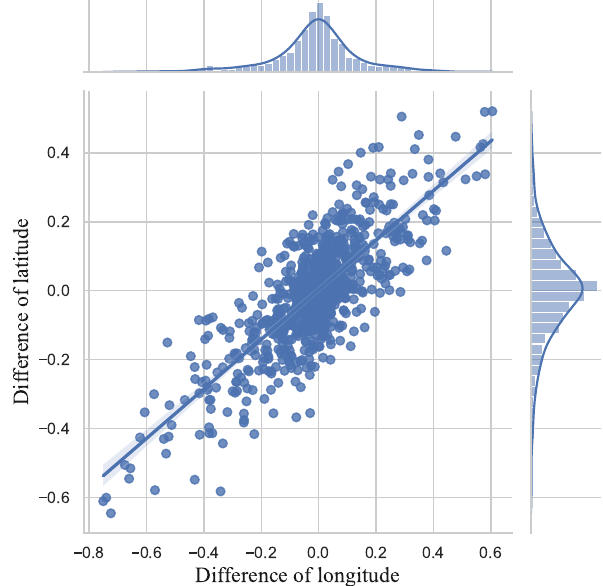
Figure 19. Plot of lightning spatial localization results for space positioning module (the dots in the graph represent the difference between the predicted and observed latitude and longitude of the